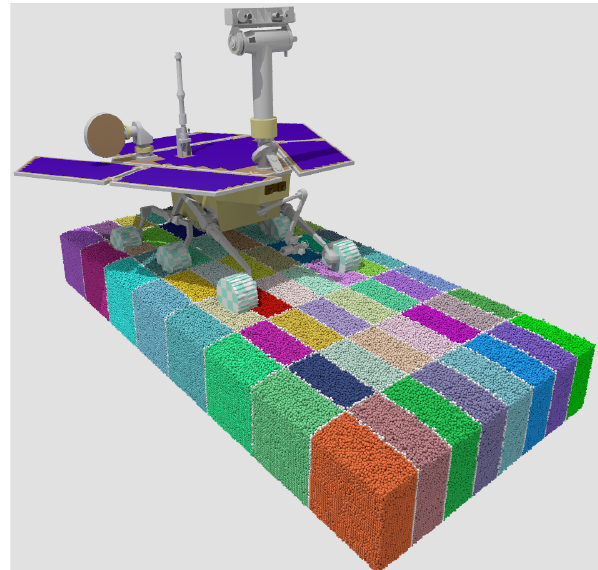
Figure 8. Snapshot of Mars Rover simulation with 2016000 terrain Figure 8 : Snapshot of Mars Rover simulation with 2,016,000 ter- particles using 64 sub-domains. Bodies are colored by sub-domain, rain particles using 64 sub-domains. Bodies are colored by sub- with shared bodies (those which span sub-domain boundaries) col- domain, with shared bodies (those which span sub-domain bound- aries) colored white.